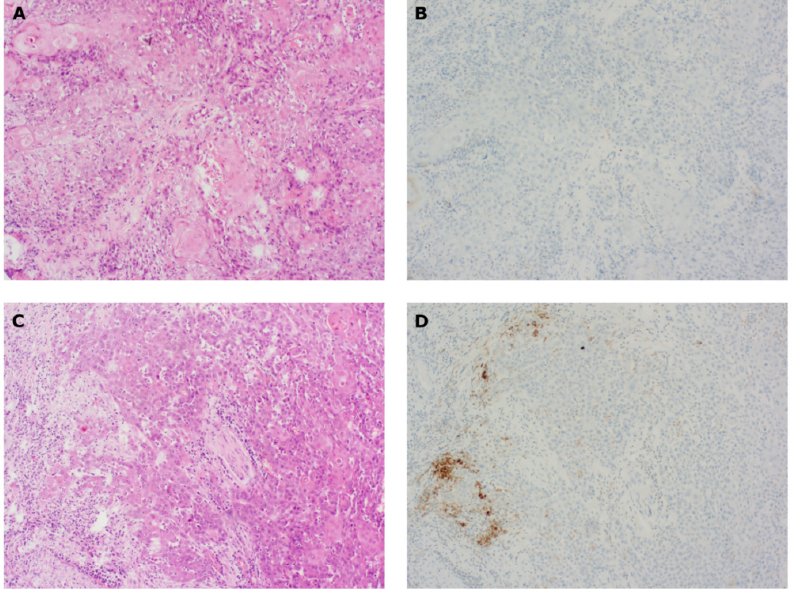
Figure 1. Effect of insufficient stroma present on PD-L1 CPS in paired specimens. All samples were derived from the same SCCHN patient and stained with HE ( A , C ) or PD-L1 ( B , D ). ( A , B ) Biopsy from the primary tumor with insufficient tumor stroma and absent PD-L1 staining (CPS = 0). ( C , D ) Resection specimen from the primary tumor with adequate amount of tumor stroma. PD-L1 staining was absent on TCs but partially present on ICs (CPS = 5). CPS, combined positive